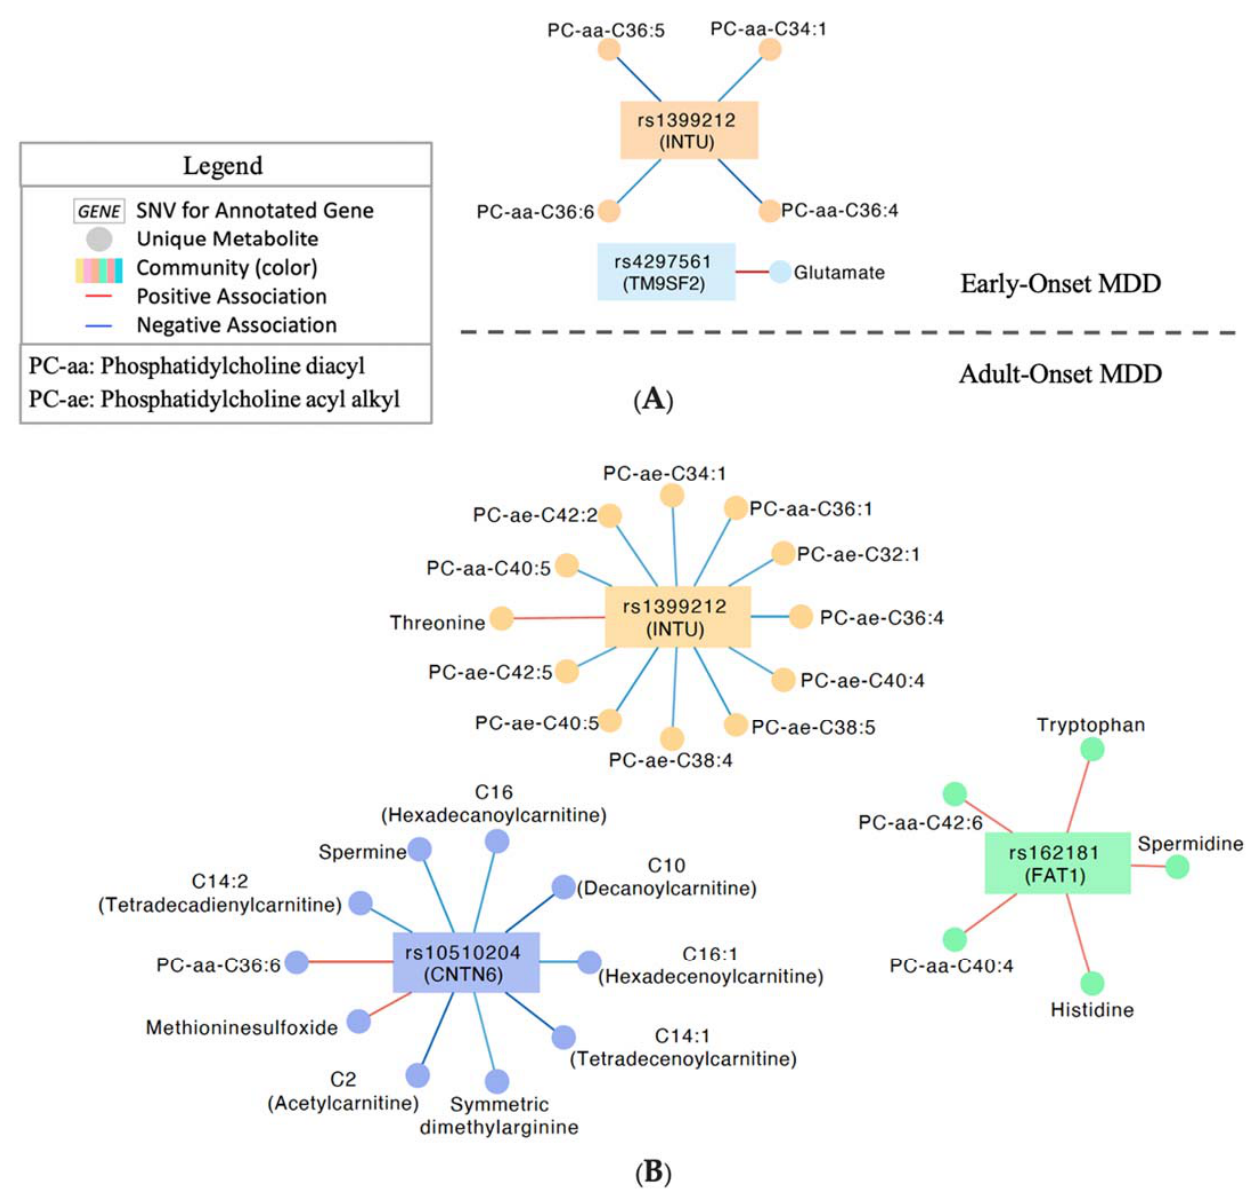
Figure 2. Multi ‐ Omics integration network analysis. ( A ) Significant ( p < 0.05; |r| > 0.1) associations of SNVs and metabo ‐ lites in individuals with depressive onset prior to age 18. ( B ) Significant ( p < 0.05; |r| > 0.1) associations in individuals with depressive onset at or after age 18. Legend applies to both ( A ) and ( B